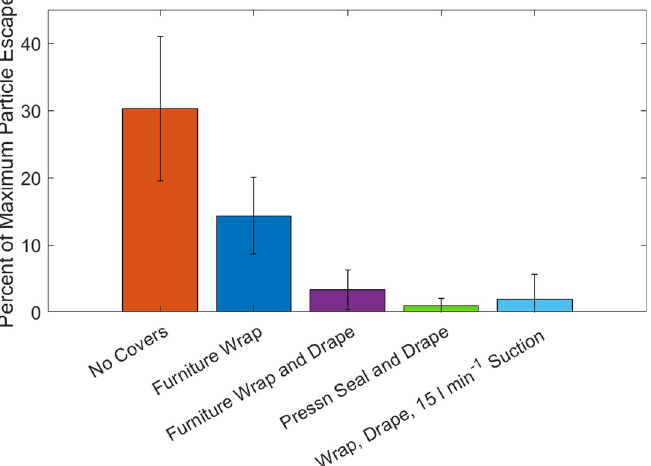
Fig 2. Effectiveness of different enclosure covering approaches and materials: Ratio of the maximum aerosol number concentration measured inside vs. measured outside the enclosure for particles larger than 0.1 micrometers when various types of one-layer of plastic covering with or without an added Steri-Drape layer were placed over the front and side holes in the enclosure.